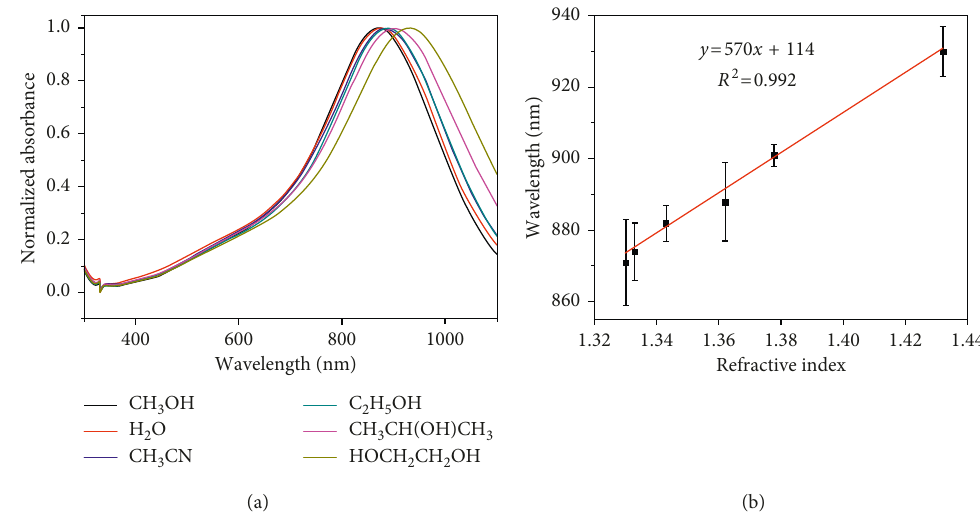
� 1.3301), H � 1.333), CH � 1.343), 3 OH ( n 2 O ( n 3 CN ( n